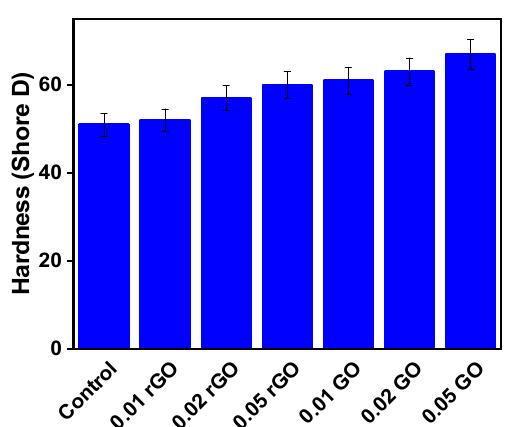
similar polarity. On the other hand, a further increase in hardness could be observed with the incorporation of GO due to the presence of oxygenated groups that are more likely to form stronger interactions with the urethane linkages, which led to increments in hardness values [31,65].